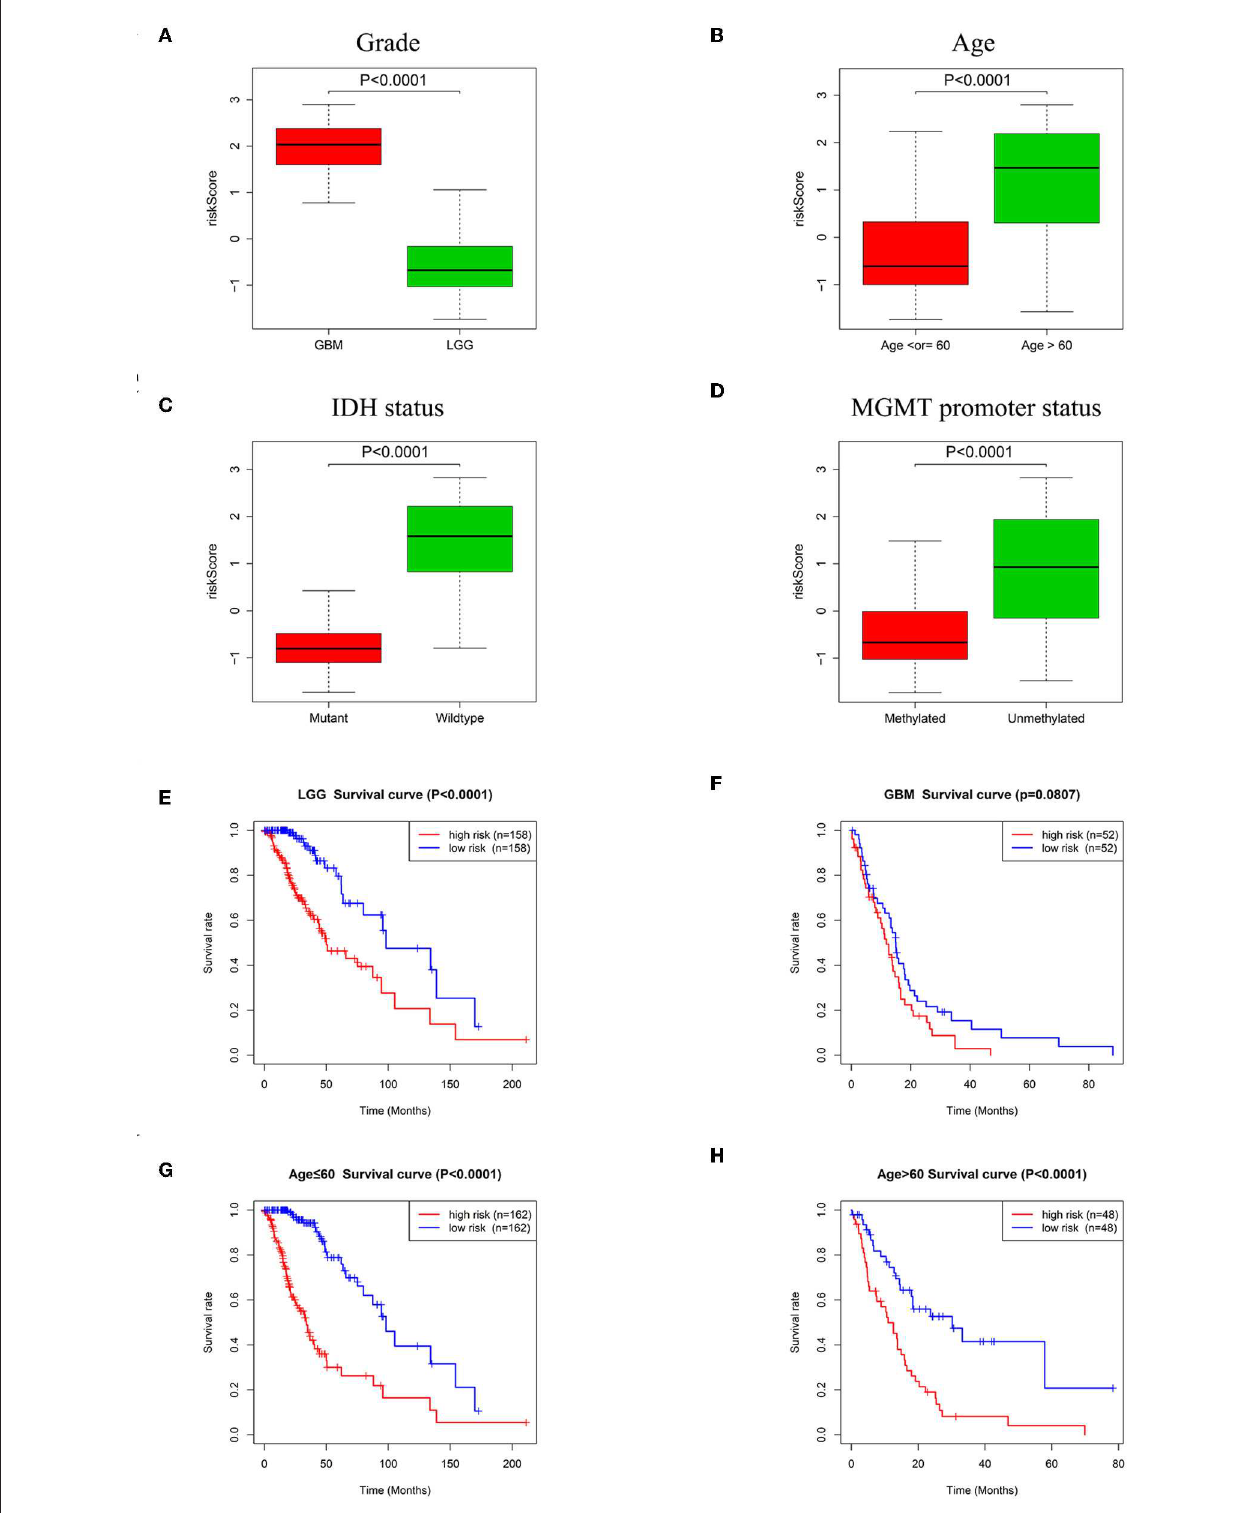
FIGURE 6 | Association between the risk signature and different cohorts stratified by glioma grade, age, IDH status and MGMT promoter status. (A) Risk scores in GBM were higher than that in LGG ( P < 0.0001). (B) Patients > 60 years old had higher risk scores than patients ≤ 60 years old ( P < 0.0001). (C) Risk scores in IDH mutation samples were lower than IDH wildtype samples ( P < 0.0001). (D) Risk scores in MGMT promoter methylated samples decreased compared with samples